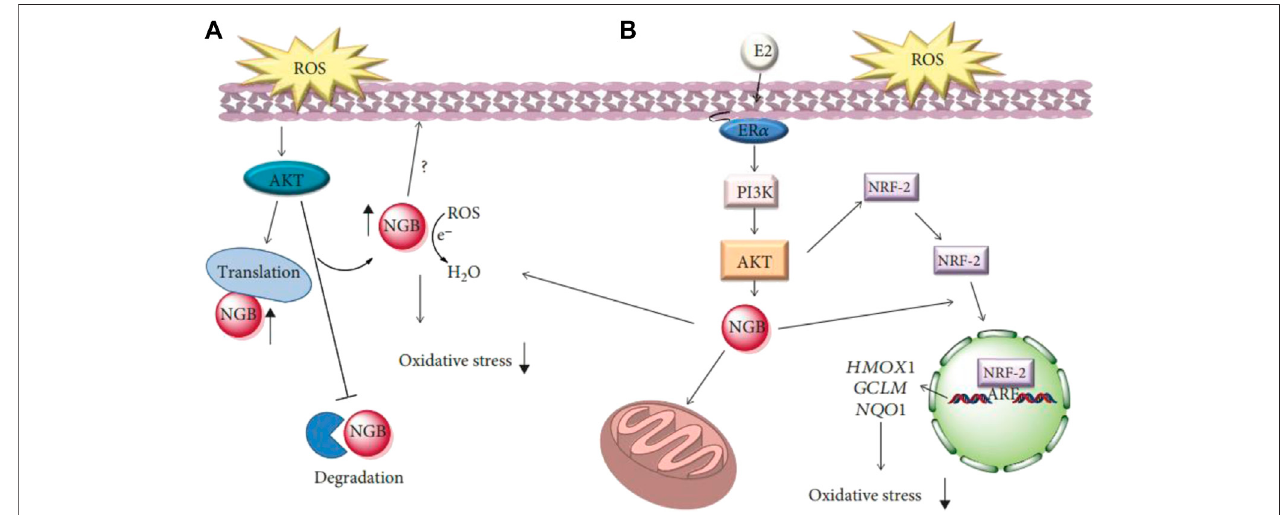
FIGURE3|(A) SchematicmodelofROS-activatedsignalinginvolvedintherapidmodulationofneuroglobin(NGB)levels,itslocalization,andfunctionontheredox balance outside mitochondria. (B) Schematic model of the impact of E2 intracellular-activated pathway on NGB expression, localization. The NRF-2 pathway describes how NGB affects the E2-dependent activation of the antioxidant NRF-2 system. E2: 17 β -estradiol; ER α : estrogen receptor α ; PI3K: phosphatidylinositol three kinase (Fiocchetti et al., 2019).